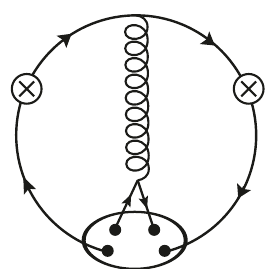
Figure 18. Feynman diagram of the contribution of the four-quark condensate to the two-point Green functions due to the e(cid:11)ective propagation of the nonlocal quark-gluon